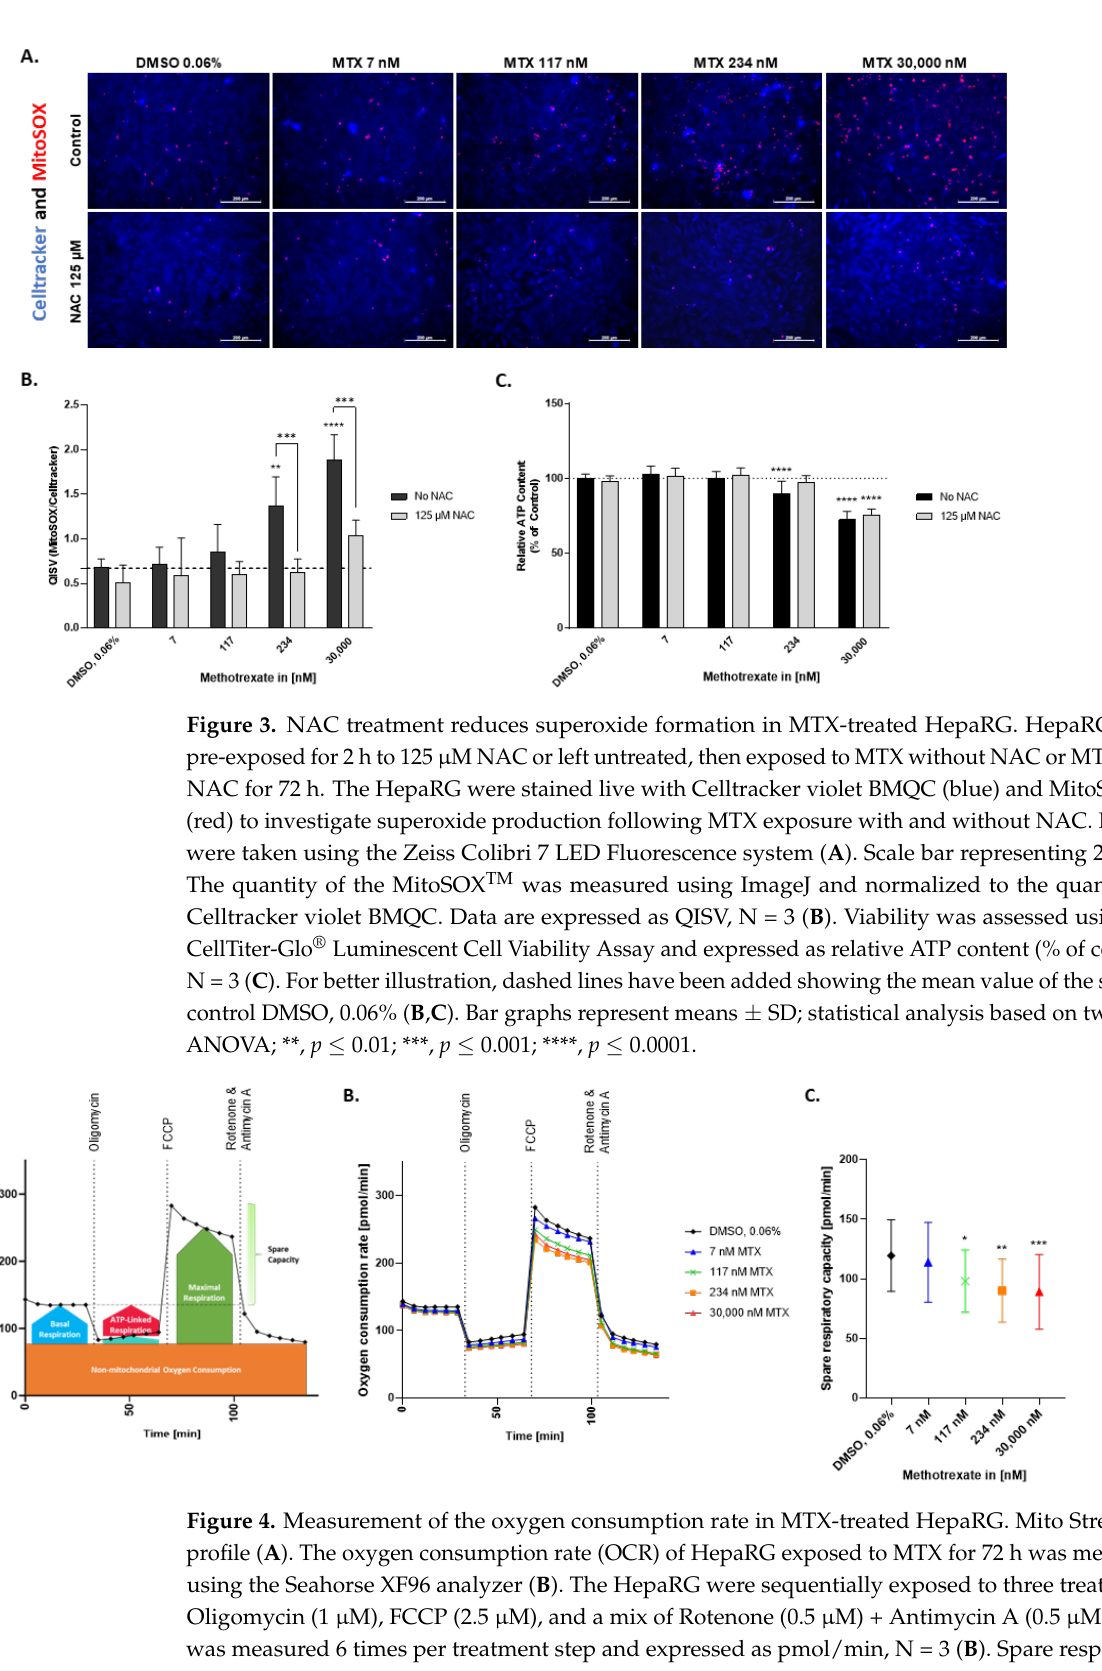
Figure 5. Effect of NAC on oxygen consumption rate in MTX treated HepaRG. The oxygen con- sumption rate (OCR) of HepaRG exposed to MTX for 72 h ( A ) or HepaRG preincubated with 125 µM NAC and then exposed to MTX for 72 h ( B ), was measured using the Seahorse XF96 analyzer. The HepaRG were sequentially exposed to three treatments: Oligomycin (1 µM), FCCP (2.5 µM), and a mix of Rotenone (0.5 µM) + Antimycin A (0.5 µM). OCR was measured 6 times per treatment step and expressed as pmol/min. Spare respiratory capacity was calculated as the delta maximal respiration to basal respiration ( C ). Graphs represent means ( A , B ), and means ± SD ( C ); statistical analysis based on two-way ANOVA; *, p ≤ 0.05; **, p ≤ 0.01; ***, p ≤ 0.001. ; N = 3.